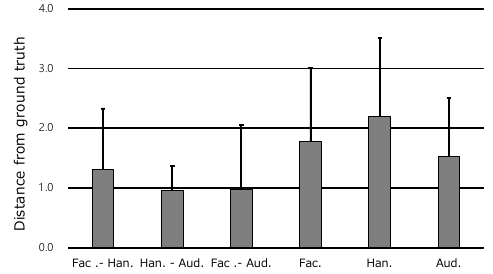
Figure 7: Distance between a ground truth and sampled activation under each condition. Fac., Han., and Aud. indicate facial expres- sion, hand movement, and auditory signals, respectively. The con- dition label shows the inputted signals (i.e., Fac.-Han. means that the model received facial expressions and hand movements signals for the